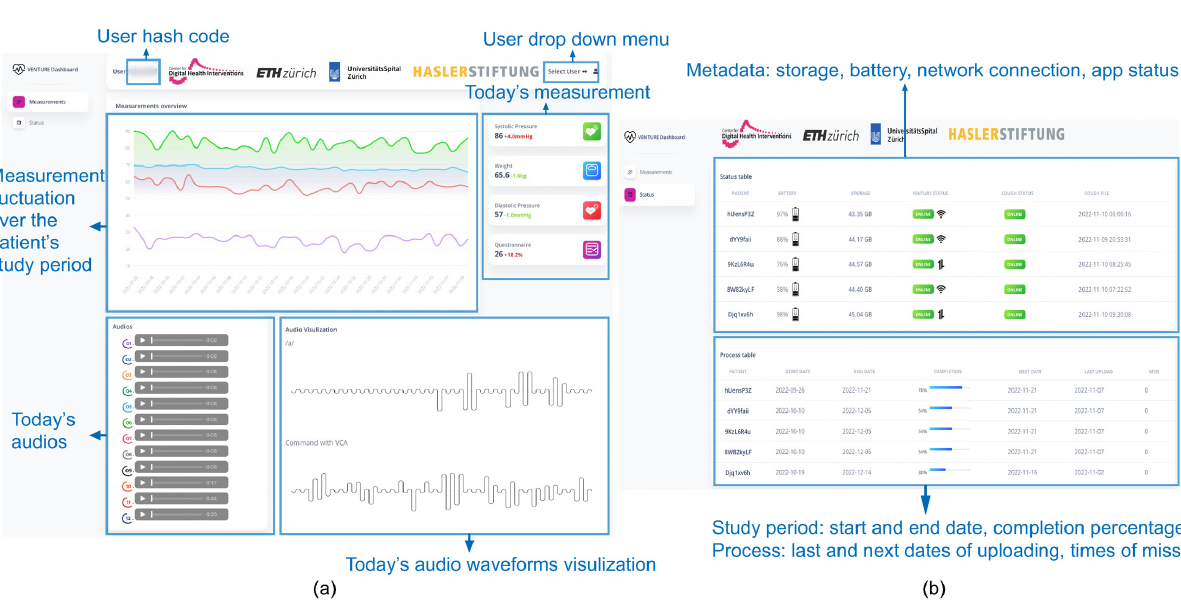
Fig 2. Dashboard. (a) The “Measurement” dashboard depicts today’s measurements and audio, numerical measurement fluctuations during the study period, and audio waveform visualization. (b) The “Status” dashboard shows the tablet’s metadata, e.g., storage, network connection, and the study